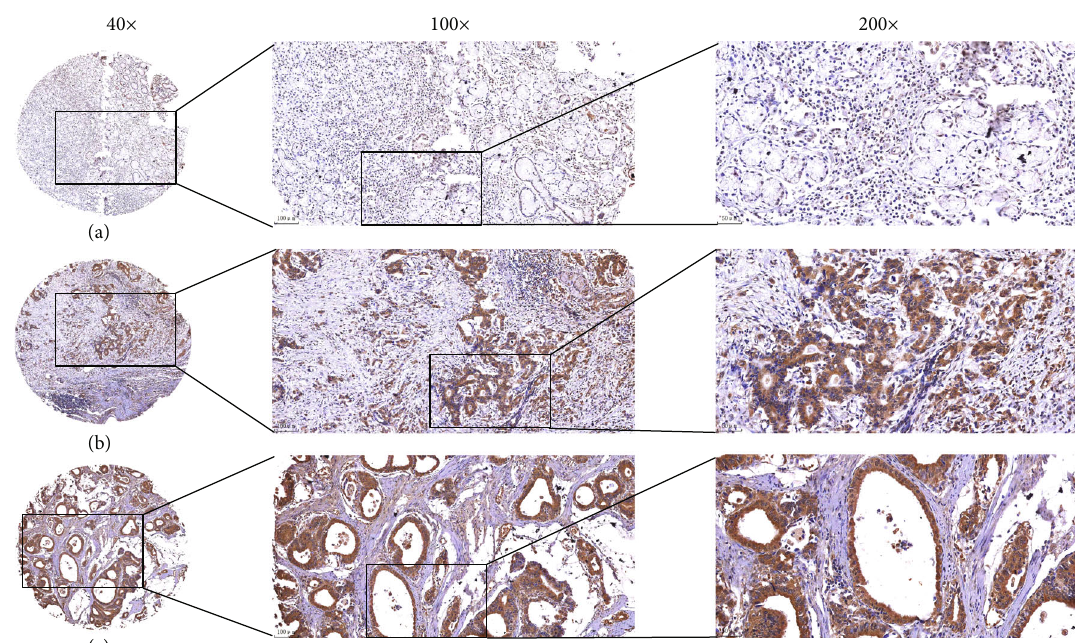
Figure 1: The expression level of ZNF521 in gastric cancer and noncancerous tissues by IHC. (a) ZNF521 was mainly localized in the cytoplasm of cancer cells, weakly expressed in noncancerous tissues, magni fi cation × 200. (b) – (d) ZNF521 was highly expressed in moderately di ff erentiated adenocarcinoma and poorly di ff erentiated adenocarcinoma, magni fi cation ×